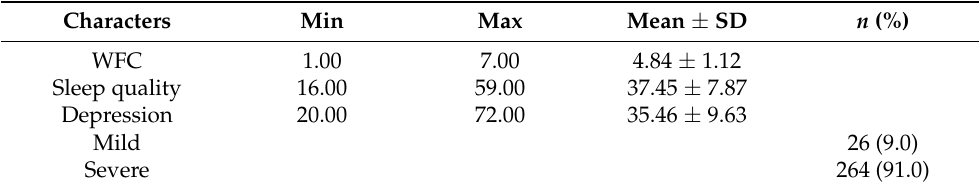
Table 3. Level of WFC, sleep quality, and depression ( n =